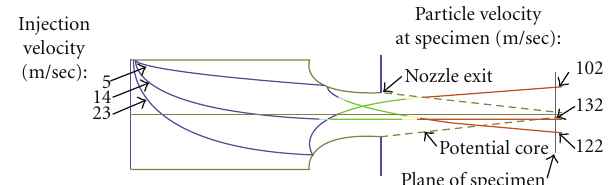
Figure 12: Most probable particle trajectories for various injection velocities in an unducted burner rig operated at a Mach number of 0.3 and a single-particle diameter of 26 microns. Note that interior bouncing can result in particles injected at higher velocities tracking toward the upper half of the test specimen, and particles injected at lower velocities can track toward the lower half of the test